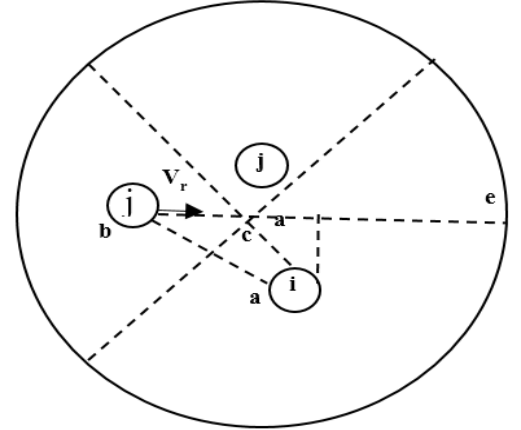
Figure 7. Approaching